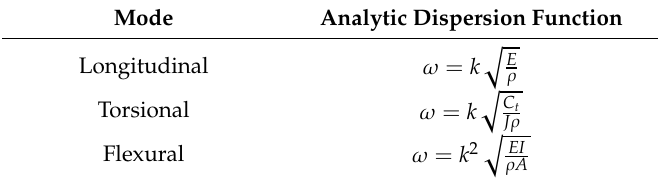
Figure 3. The dispersion curves computed by [11], for a waveguide of rectangular section 15 × 5 [mm]. Notice that in this graph the wave number is defined as k = 2 π / λ [m -1 ].